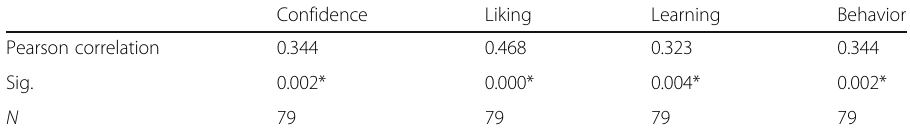
Table 9 Correlation analysis between students ’ Behavioral Intention and attitudes